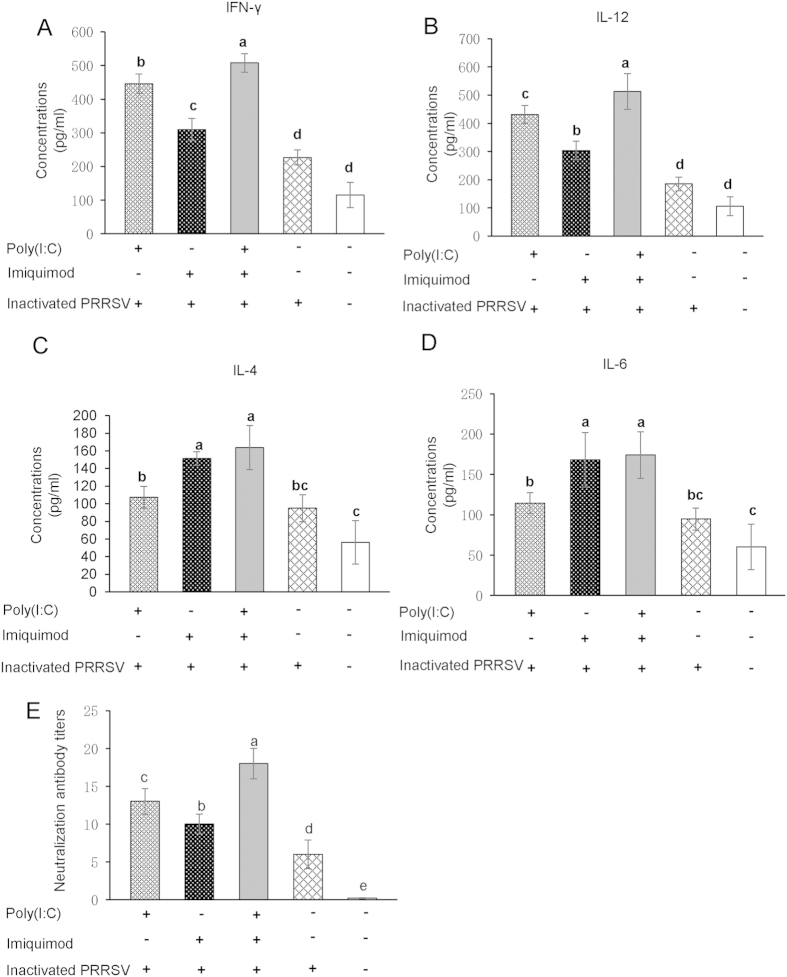
The concentrations of Th1- and Th2-type cytokines and neutralization antibody titers in the sera of immunized mice.Serum samples were collected from vaccinated mice at 49 dpi. The concentrations of Th1-type cytokines IFN-γ and IL-12, Th2-type cytokines IL-4 and IL-6 in the sera were detected by ELISA (A–D). Neutralization antibody titers were expressed as the reciprocal of the last serum dilution to neutralize 100 TCID50 of PRRSV in 50% of the wells (E). Data were shown as means ± standard deviations (error bars). Different letters (a–e) mean significant difference (P < 0.05). If there is one same letter, for example, bc and c, it means no significant difference (P > 0.05).